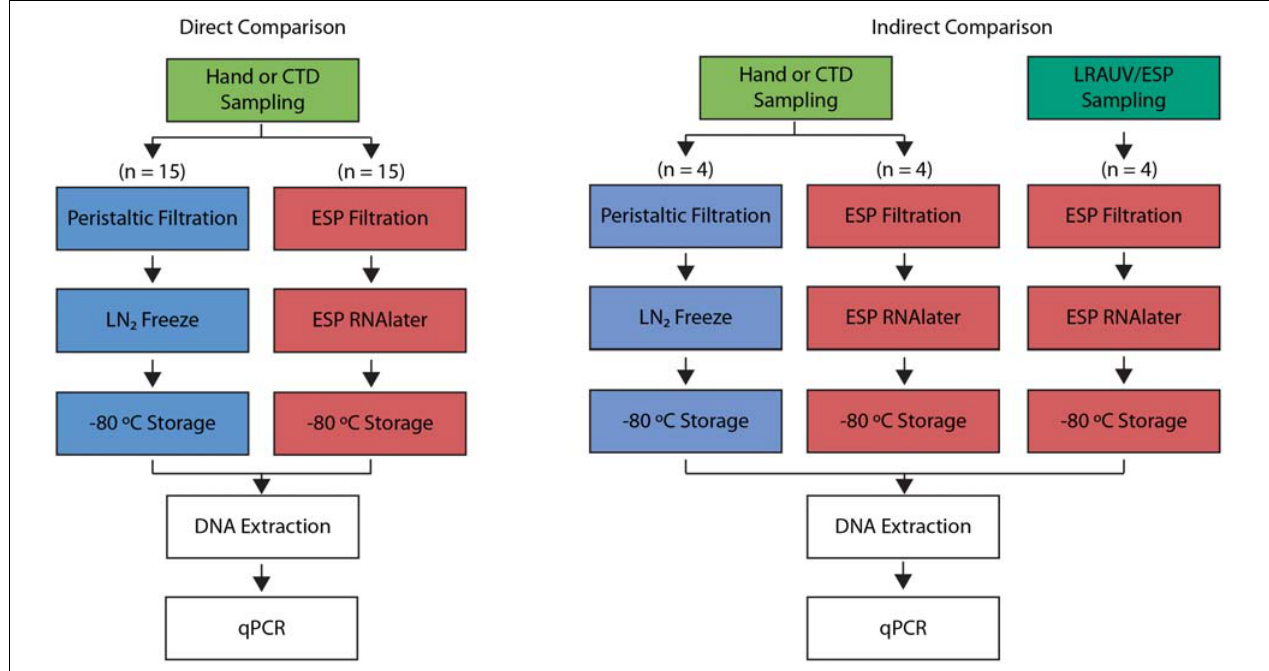
FIGURE 1 | Process diagrams of the direct (left) and indirect (right) comparison experiments. Direct comparison drew samples from the same source (green). Indirect comparisons utilized two different water sources: hand collections (green) and LRAUV-ESP collections (dark green). Traditional sample processing of peristaltic filtration followed by liquid nitrogen (LN2) freezing is shown in blue. 3G-ESP sample processing with RNAlater R (cid:13) is shown in red. DNA extractions and qPCR assays performed were the same across all